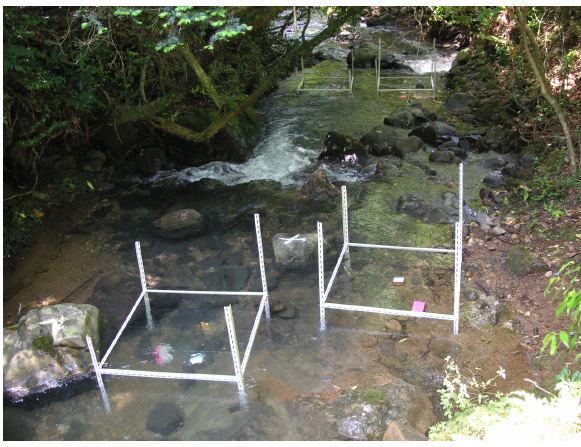
Figure 4. Plots in the mountain channel